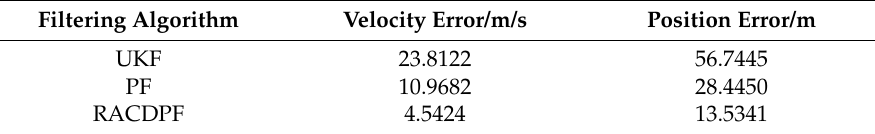
Table 6. The error statistics of the three filtering algorithms ( M = 500).